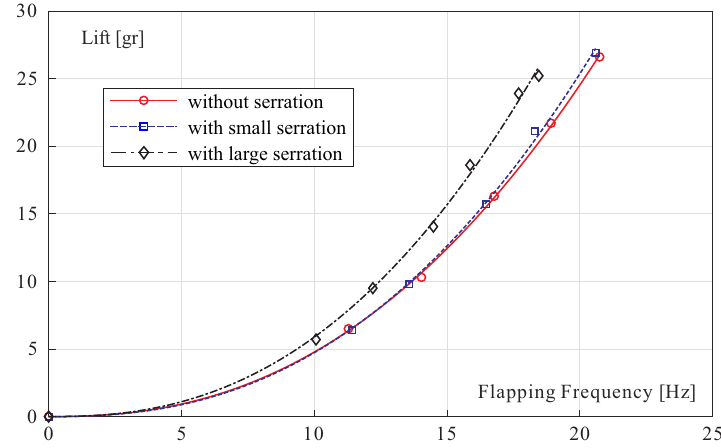
Figure 8. Lift vs. flapping frequency for the wings with trailing edge serration.